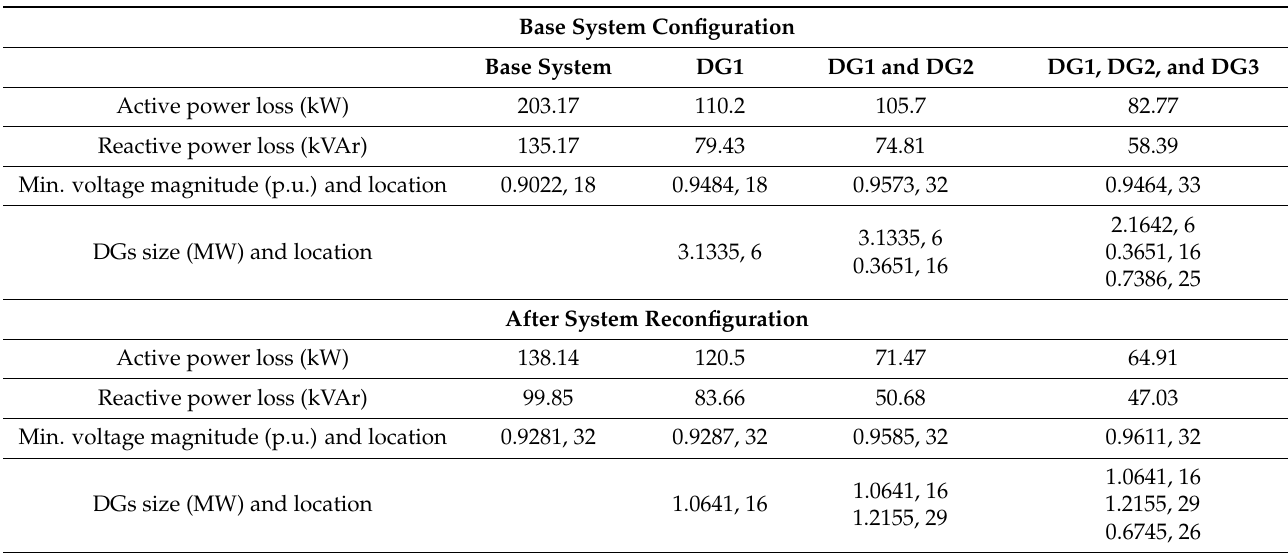
Figure 6. Losses of base and reconfigured distribution system. In scenario 4, when the three DG units are placed in the reconfigured distribution system, an outstanding reduction in power loss is observed. Multi-DG units with different sizes are installed at different locations. DG1 (1064.1 kW) is installed at bus 16, and DG1 and DG2 (1064.1 and 1215.5 kW, respectively) are installed at buses 16 and 29, respec- tively. Likewise, DG1, DG2, and DG3 (1064.1, 1215.5, and 674.5 kW, respectively) are in- stalled at buses number 16, 29, and 26, respectively, as shown in Table 1. Owing to the reconfiguration and DG installation in the network, the voltage profile increased by 6.53%, and the percent of loss reduction increased by 68.05%. The minimum voltage deviation is obtained by scenario 4. According to Table 2, four scenarios (1–4) for the IEEE-33 bus dis- tribution system are presented. Table 2. Performance of proposed method on IEEE-33 bus radial distribution network. Methods